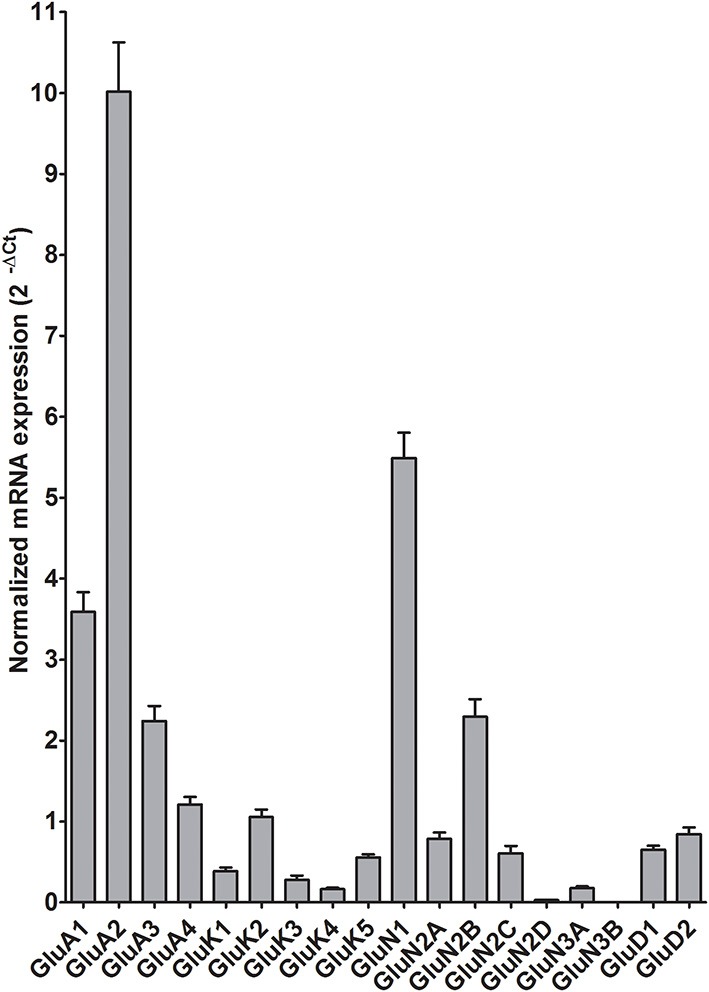
Expression of ionotropic glutamate receptor subunit mRNAs in the central amygdala of control subjects (n = 9). The mRNA level of each subunit was normalized to reference genes PGK1 and TBP and presented as mean ± standard error of the mean (SEM).